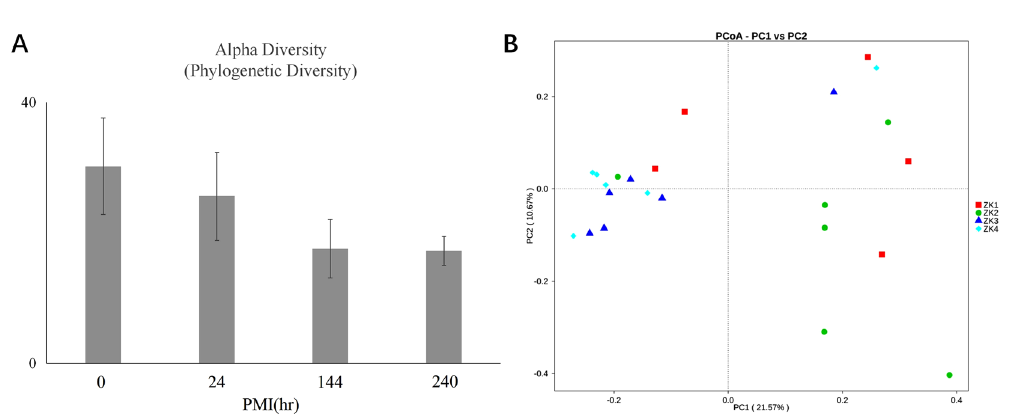
Figure 7. Diversity analysis of oral microbial communities of different PMI. ( A ) Phylogenetic distance (PD) alpha diversity for microbial communities at each group. ( B ) PCoA plot based on unweighted UniFrac distances displaying microbial communities change during death.